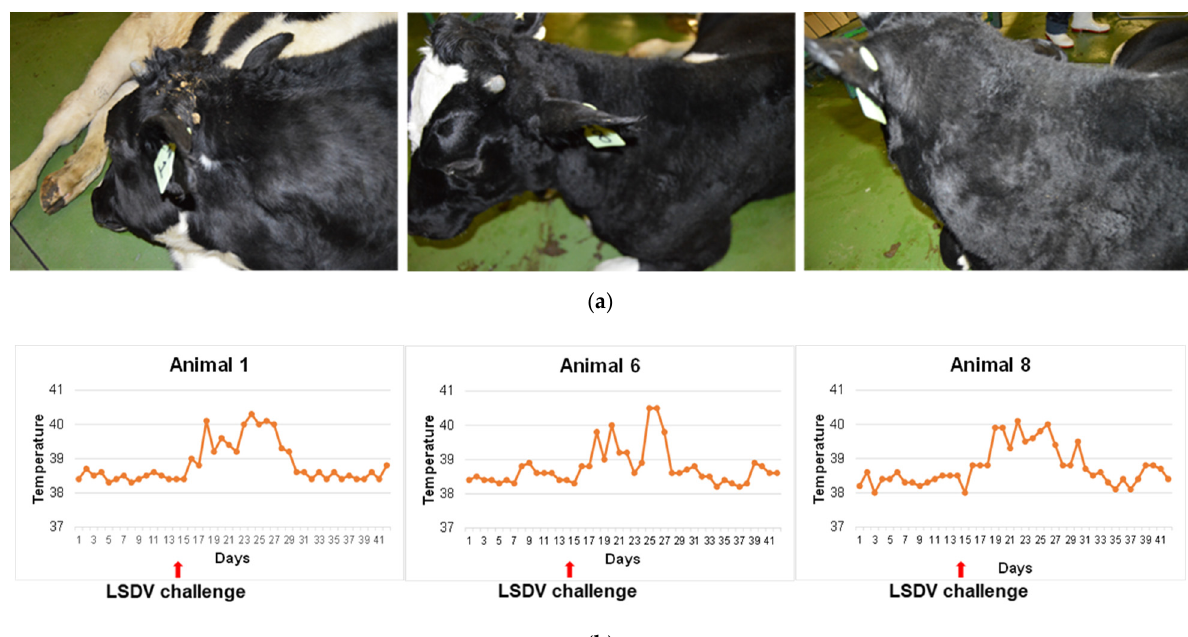
Figure 10. Naïve control group of cattle challenged with virulent LSDV. Three LSDV-negative cattle were infected with 10 7 TCID 50 virulent LSDV and observed for 28 days thereafter. ( a ) Localized swelling photographed 14 days post infection; ( b ) temperatures of the three control animals for a period of 14 days prior to challenge and 28 days post challenge.